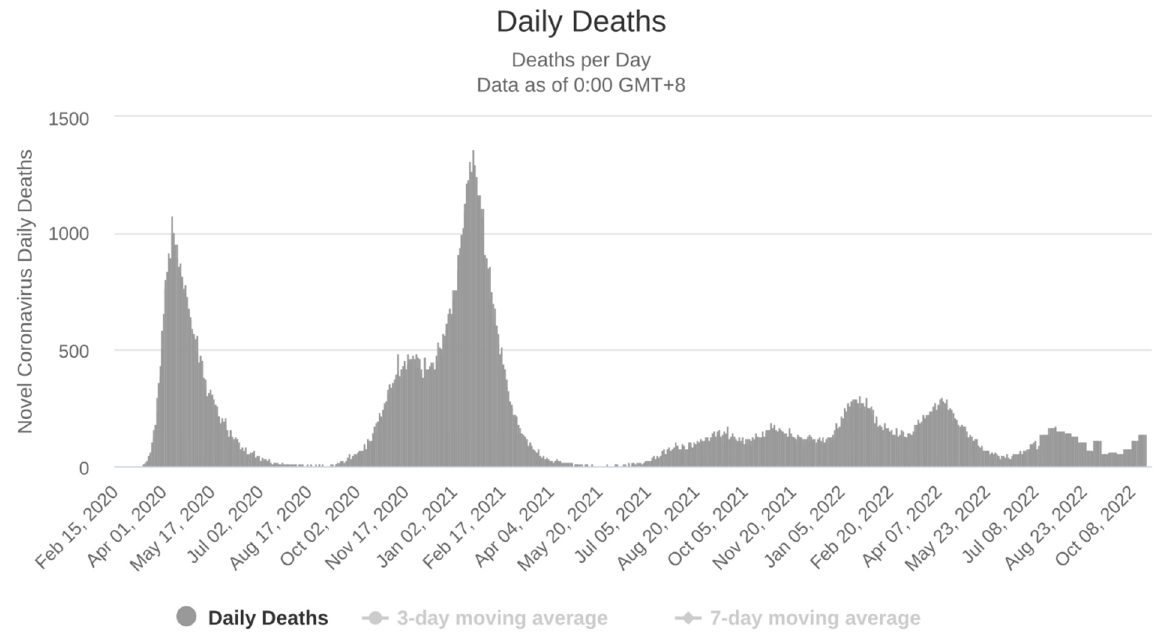
Figure 9. COVID-19 trends in deaths in the United Kingdom.